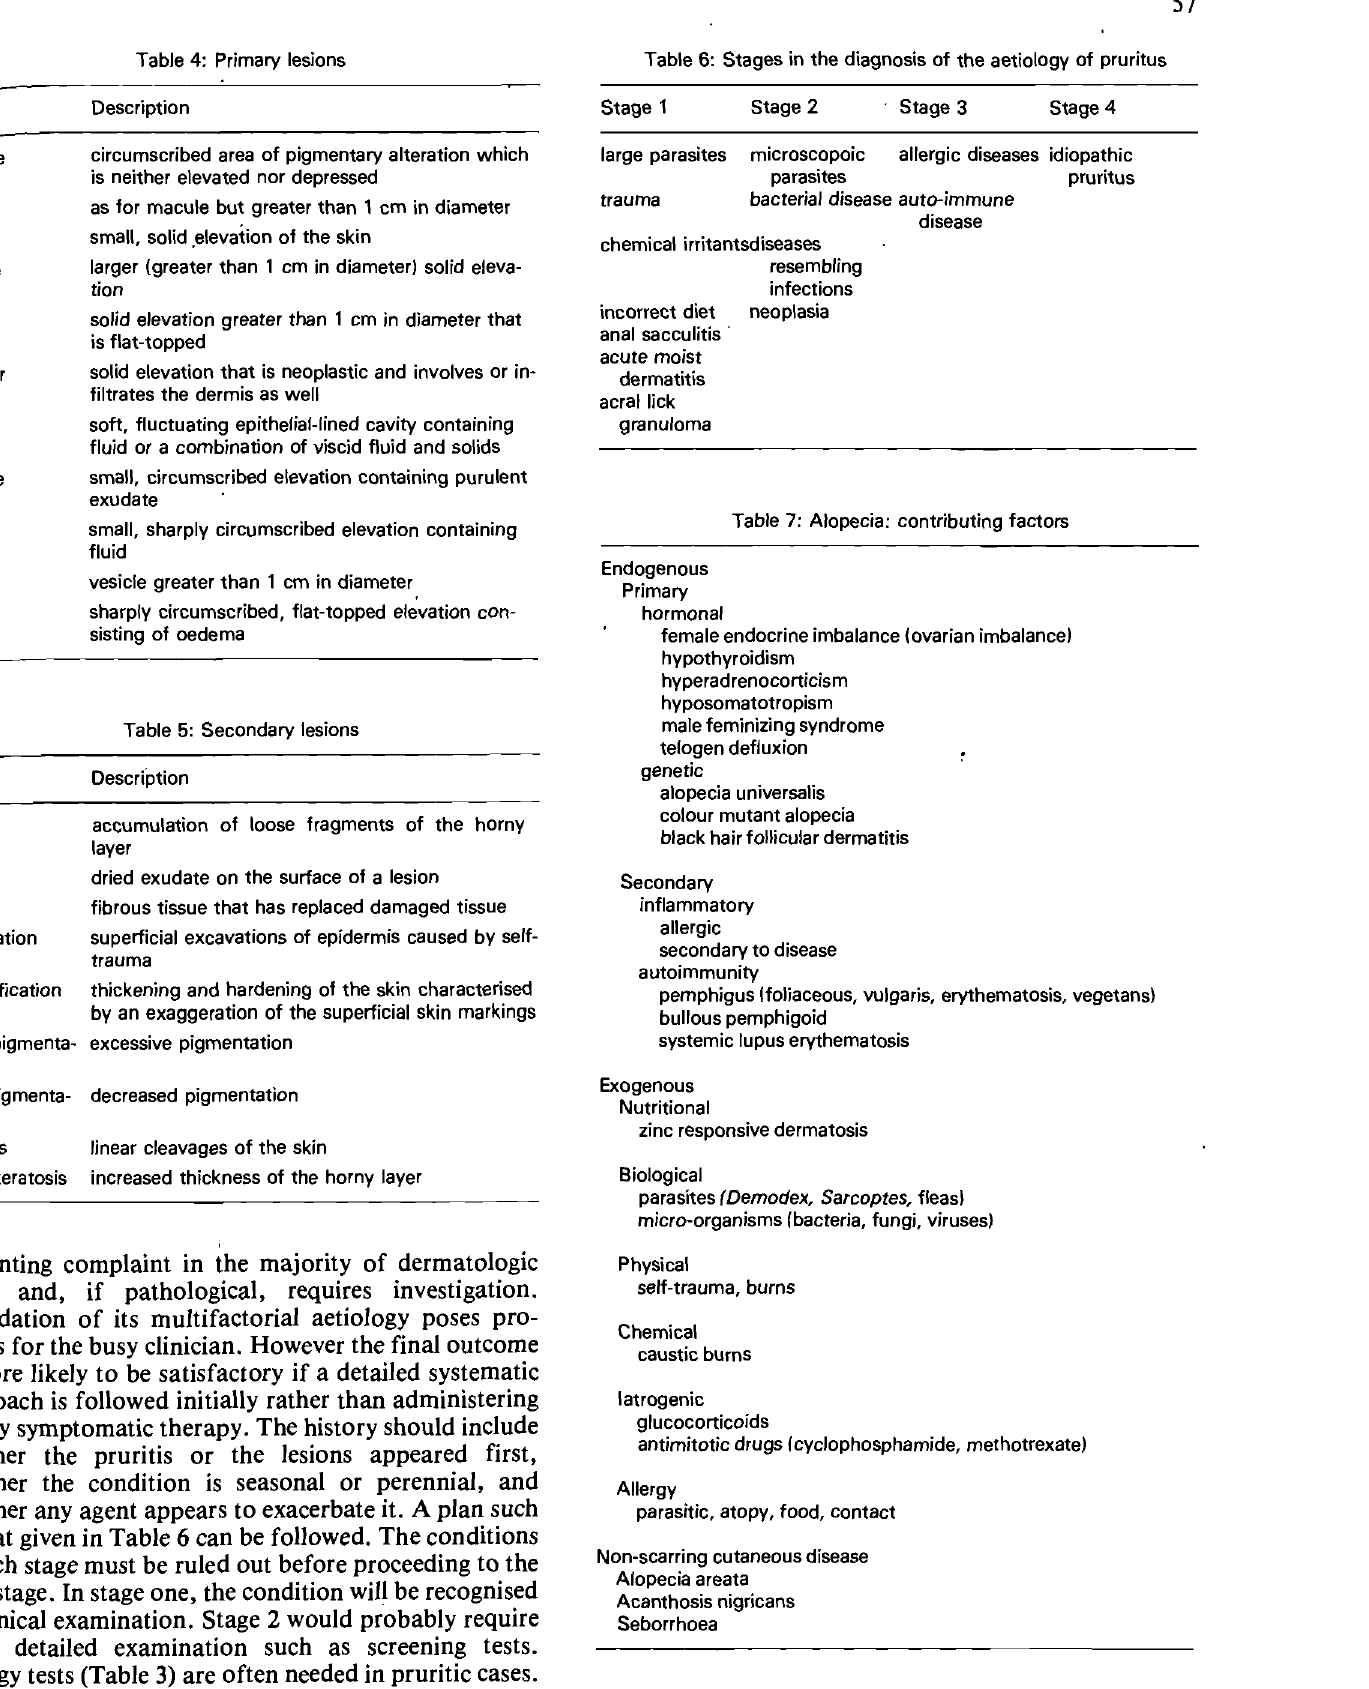
Table 6: Stages in the diagnosis of the aetiology of pruritus